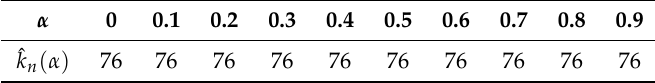
Table 1. The values of ˆ k n ( α ) based on the temperature